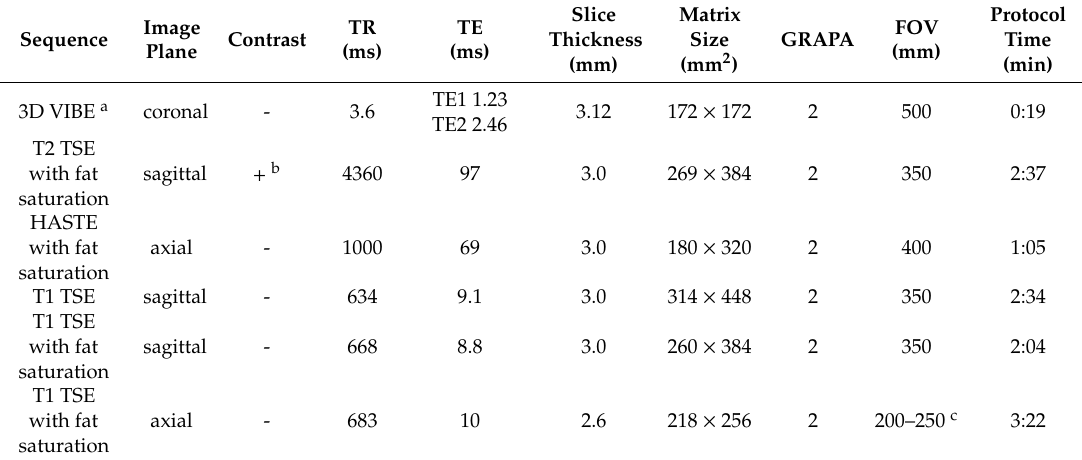
Table 1. Technical parameters for MRI sequences of integrated FDG-PET / MRI in this